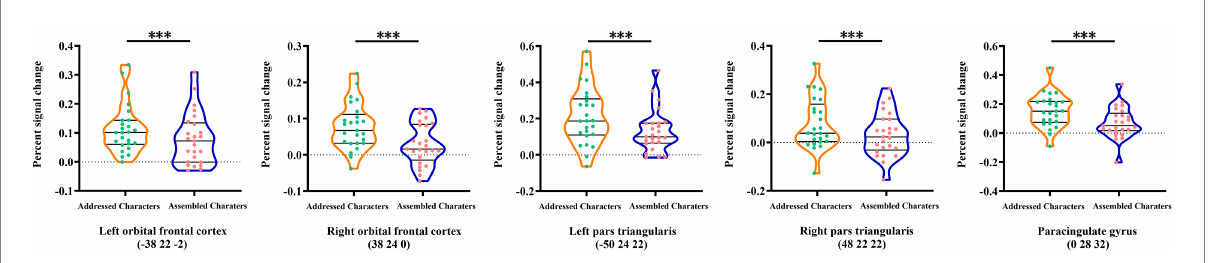
FIGURE 6 Activation differences between addressed and assembled characters in the five brain regions showing significant brain-behavior correlation. *** p <